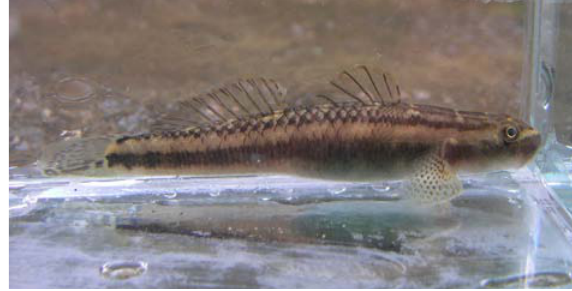
Image 13 Stiphodon multisquamus (female). Image 14 Stiphodon multisquamus (another female).